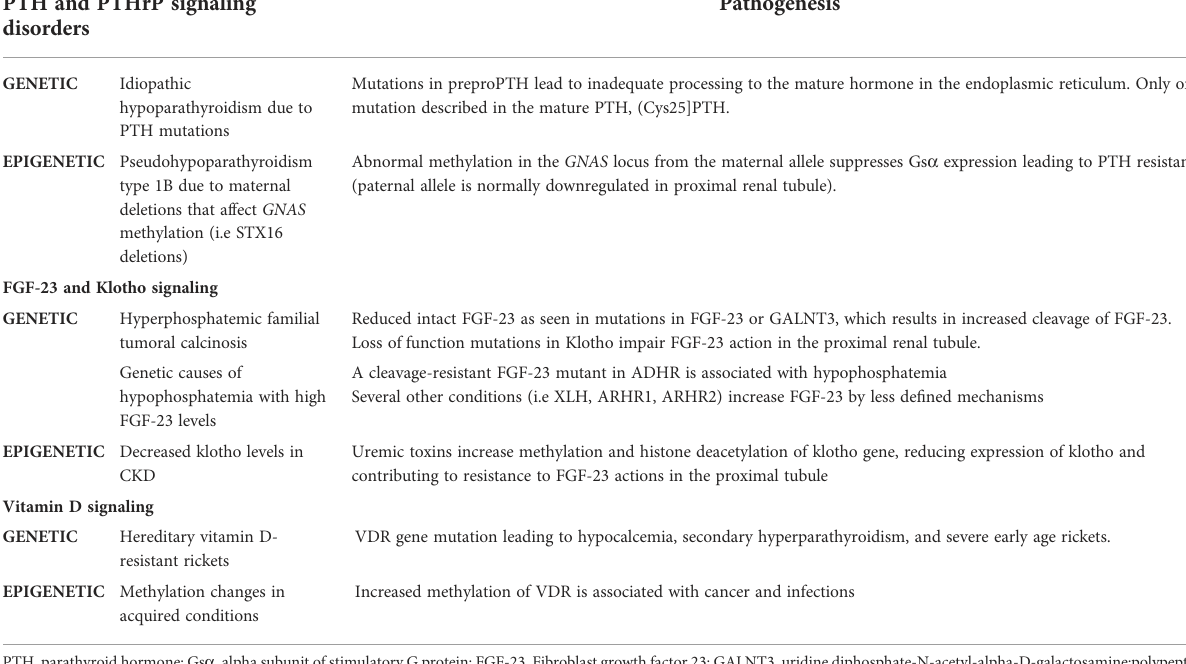
TABLE 1 Clinical examples of genetic and epigenetic disorders involving PTH, FGF-23 and Vitamin D. PTH and PTHrP